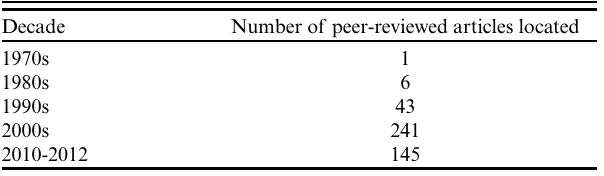
Table 1 . Participatory environmental monitoring–related peer- reviewed articles through